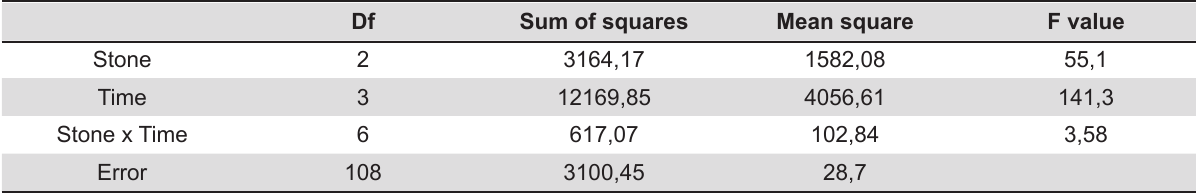
Table 3- Variance analysis